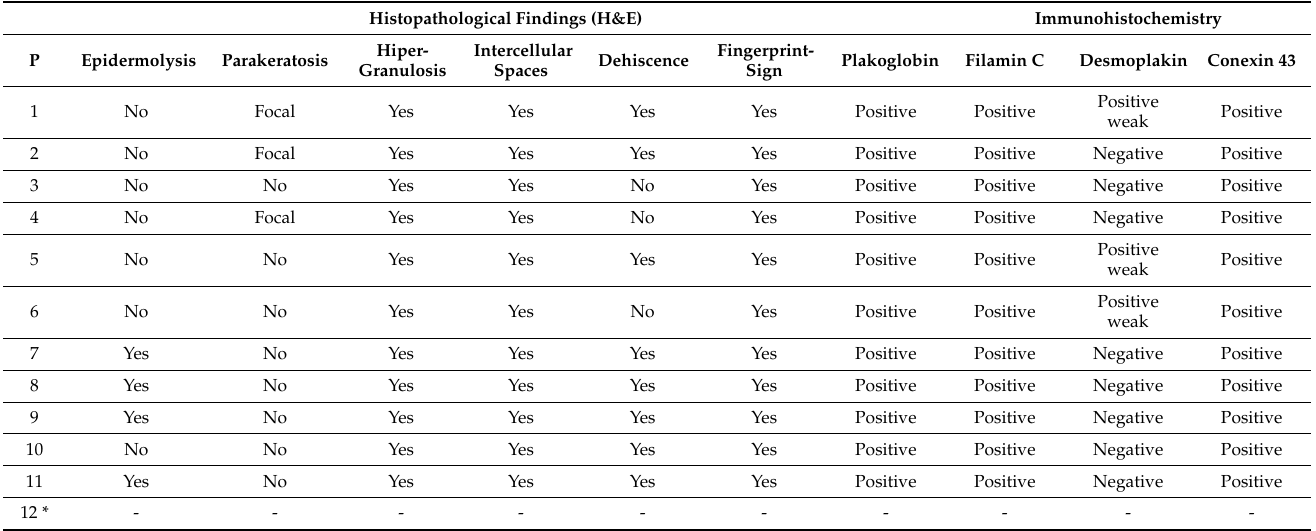
Table 2. Main histopathological